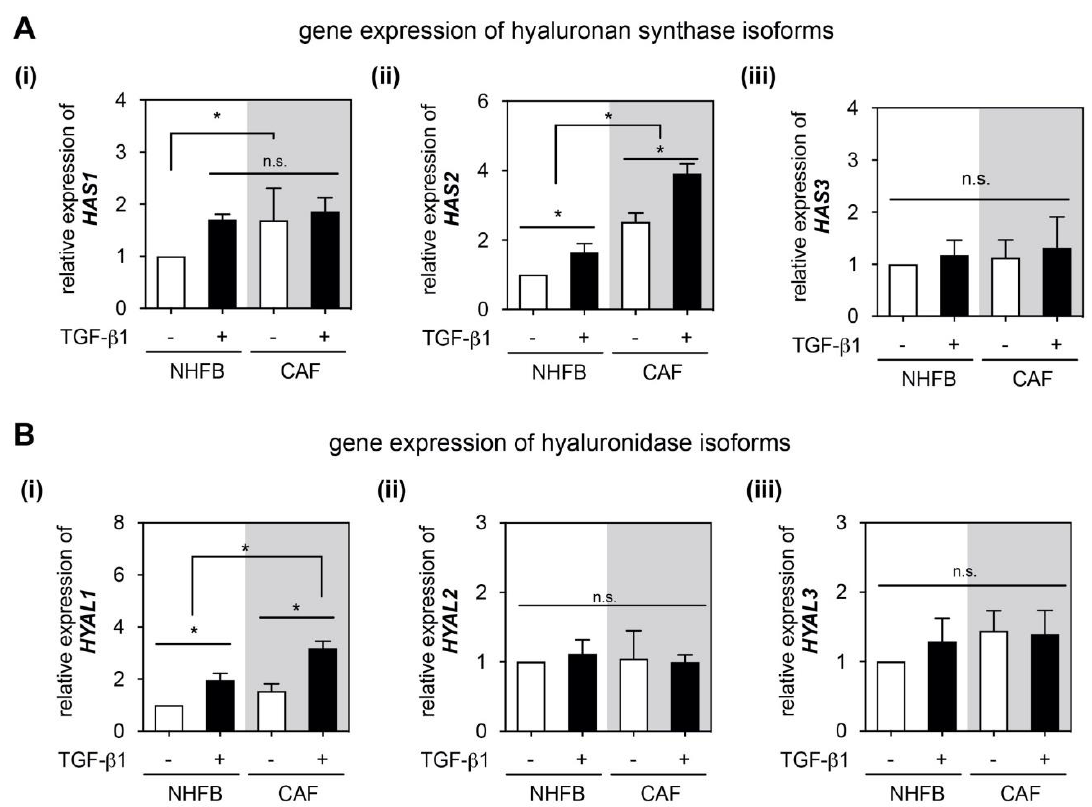
Figure 5. Gene Expression of HA related metabolic enzymes. Quantitative analysis of gene expression of ( A ( i )) HAS1, ( A ( ii )) HAS2 and ( A ( iii )) HAS3, and ( B ( i )) HYAL1, ( B ( ii )) HYAL2 and ( B ( iii )) HYAL3 of FB and CAF in dependence of TGF- β 1 presentation. Data are normalized to NHFB without TGF- β 1 treatment. Data are represented as mean ± SD; *—significance level of p < 0.05; n.s.—not significant. For all quantitative experiments were performed at least 3 replicates with fibroblasts and CAF from 3 different donors for each condition.